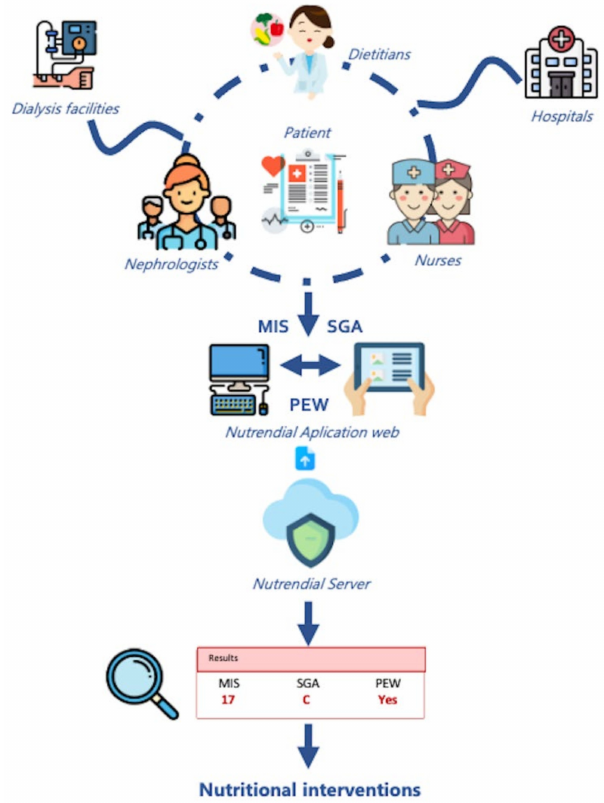
Figure 2. Nutrendial Web Application. Icons drawn by Surang, Freepikcompany, Paulalee, Flat icons, Ultimatearm and Eucalyp from www.flaticon.com (accessed on 29 March 2022). Figures shown in results box are examples